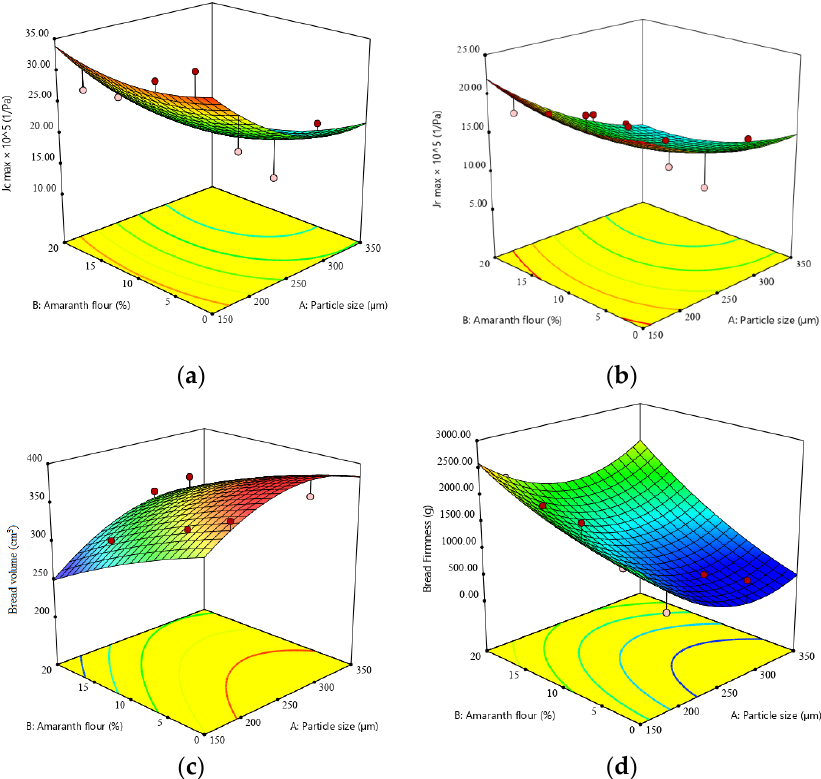
Figure 6. Three-dimensional response surface plots showing the interaction between amaranth flour particle size and addition level on: ( a ) maximum creep compliance (Jc max ); ( b ) maximum recovery compliance (Jr max ); ( c ) bread volume (BV); and ( d ) bread firmness (BF).